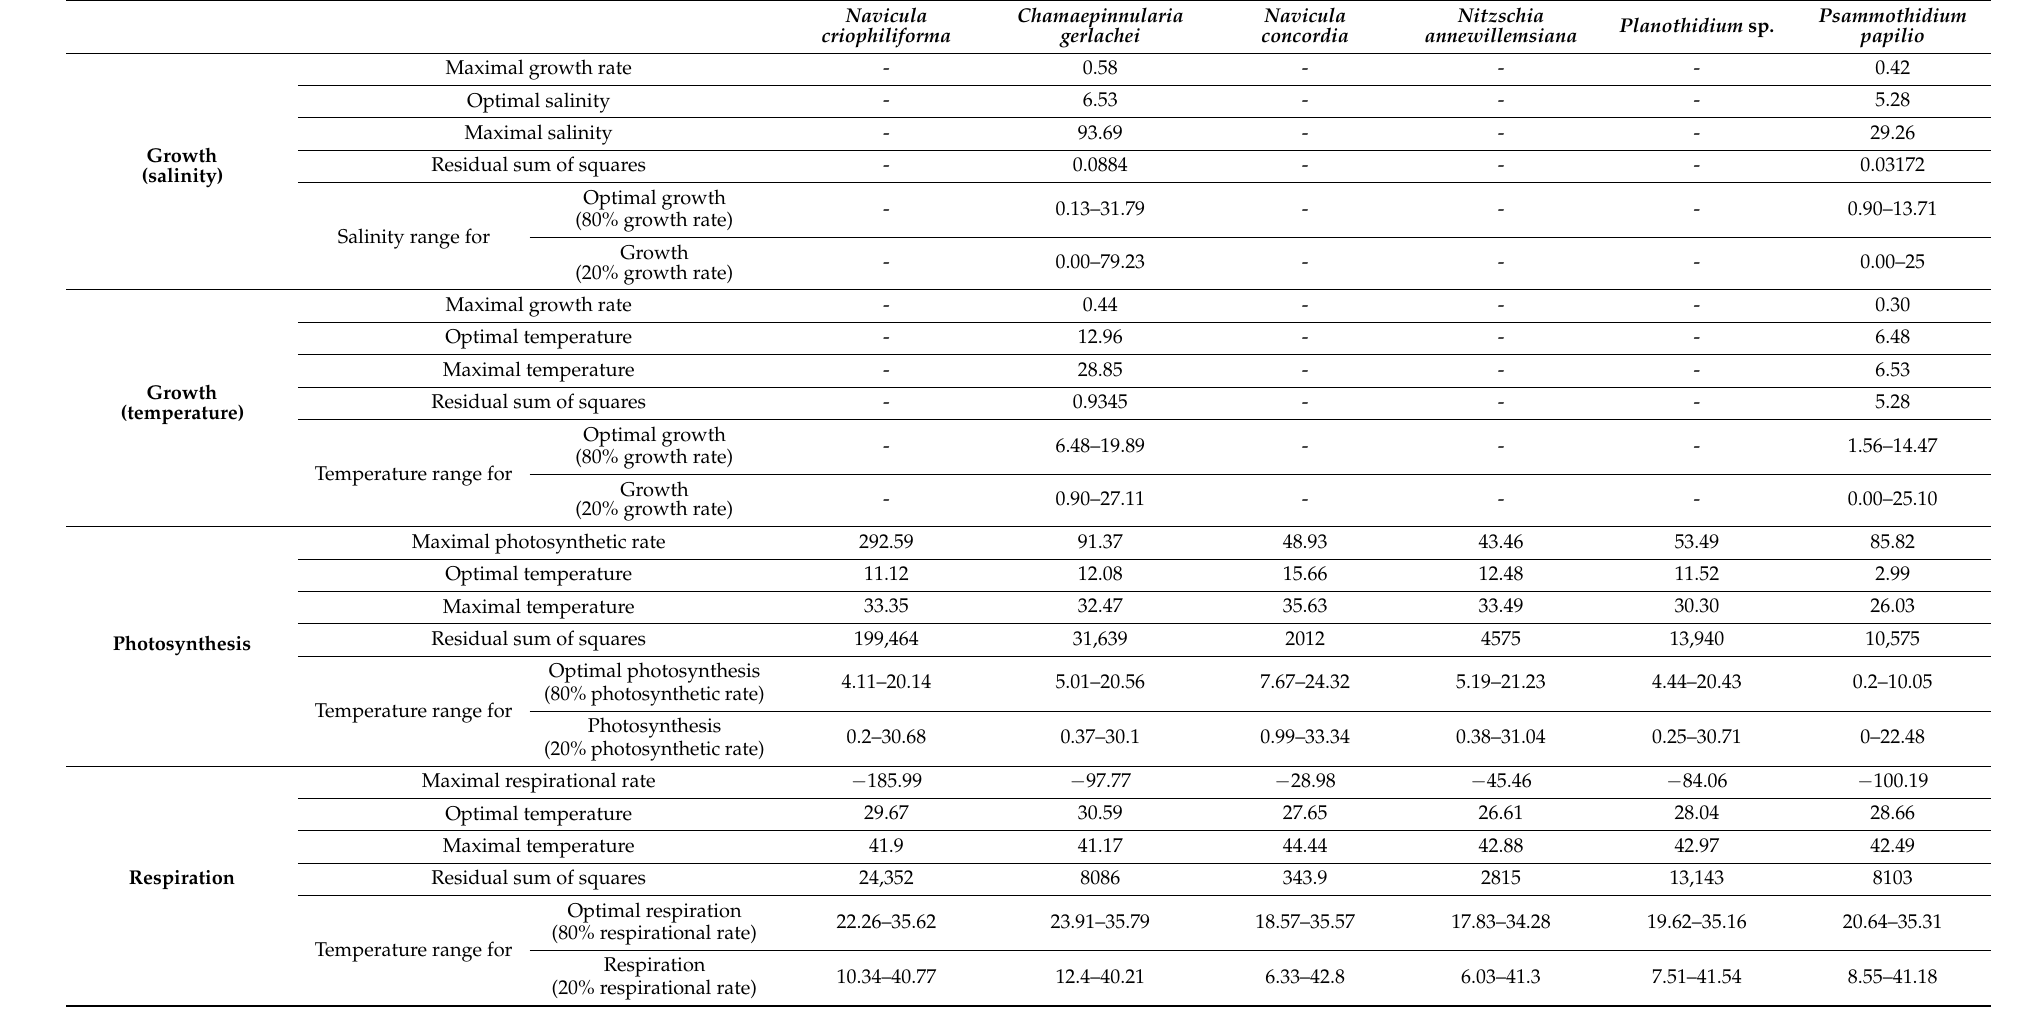
Table 4. Results of model calculation for temperature-dependent growth rate, photosynthetic rate, respirational rate, and salinity-dependent growth rate, following the model of Yan and Hunt